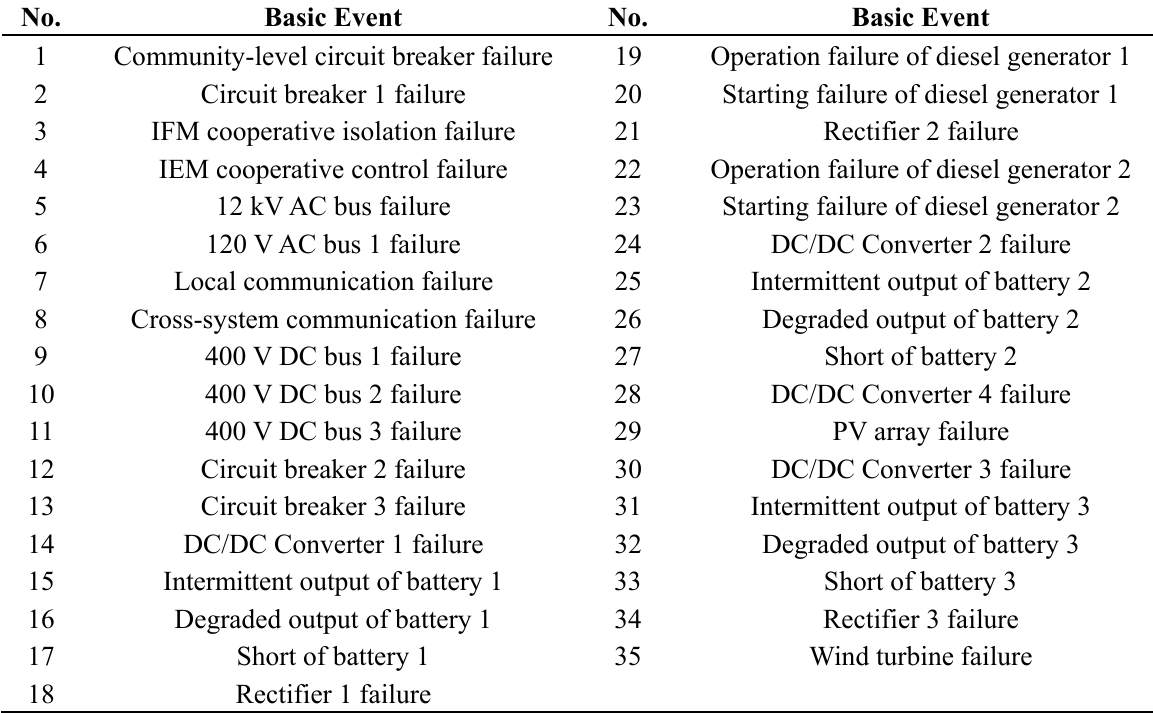
Table 2. Basic events of the fault